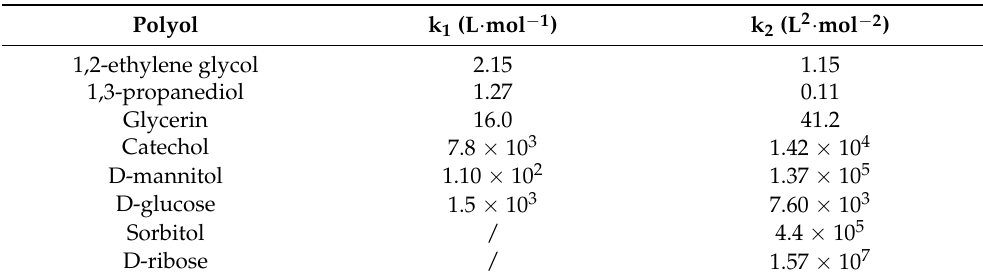
Table 3. Equilibrium constants for boric complexes with polyols (Adapted with permission from Ref. [17]. 1997,